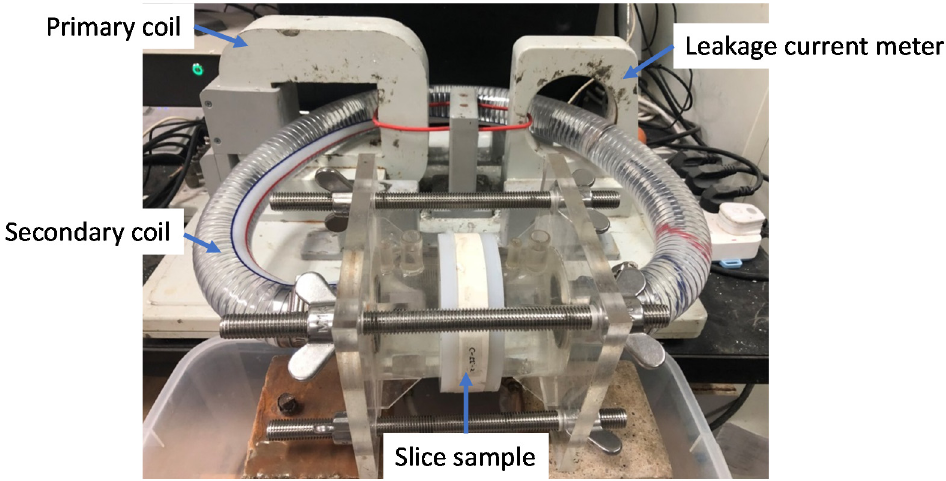
Figure 2. The modified non-contact electrical resistivity measurement setup.